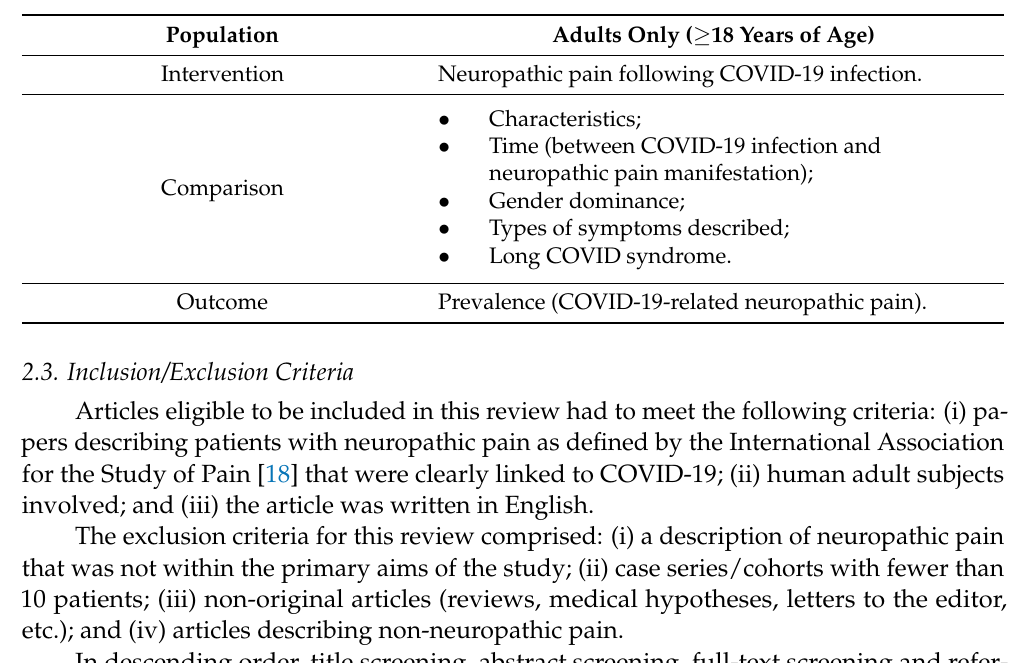
Table 1. PICO criteria applied to literature/systematic search